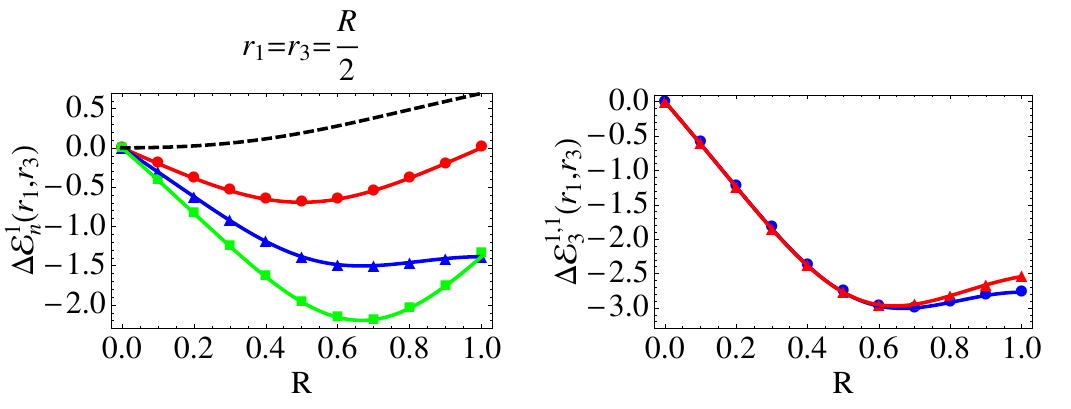
Figure 8 . Left: Results for k (cid:16) 1 and p (cid:16) 4 (cid:25) with n (cid:16) 2 (dots), n (cid:16) 3 (triangles), and n (cid:16) 4 (squares). The dashed curve is the logarithmic negativity, showing once again the gradual change in curvature as n (cid:209) 1. The symbols are numerical data and the solid curves are obtained from the formula (2.3). The dashed curve is obtained from (2.5). Right: The replica logarithmic negativity for n (cid:16) 3 and a state of two distinct excitations of momenta p 1 (cid:16) 3 (cid:25) and p 2 (cid:16) 4 (cid:25) . The circles give data for r 1 (cid:16) r 3 (cid:16) R and the triangles correspond to r 1 (cid:16) 2 R and r 3 (cid:16) 3 R . Agreement with the 2 5 5 analytic curves is again excellent. These correspond to twice the replica logarithmic negativity of a single